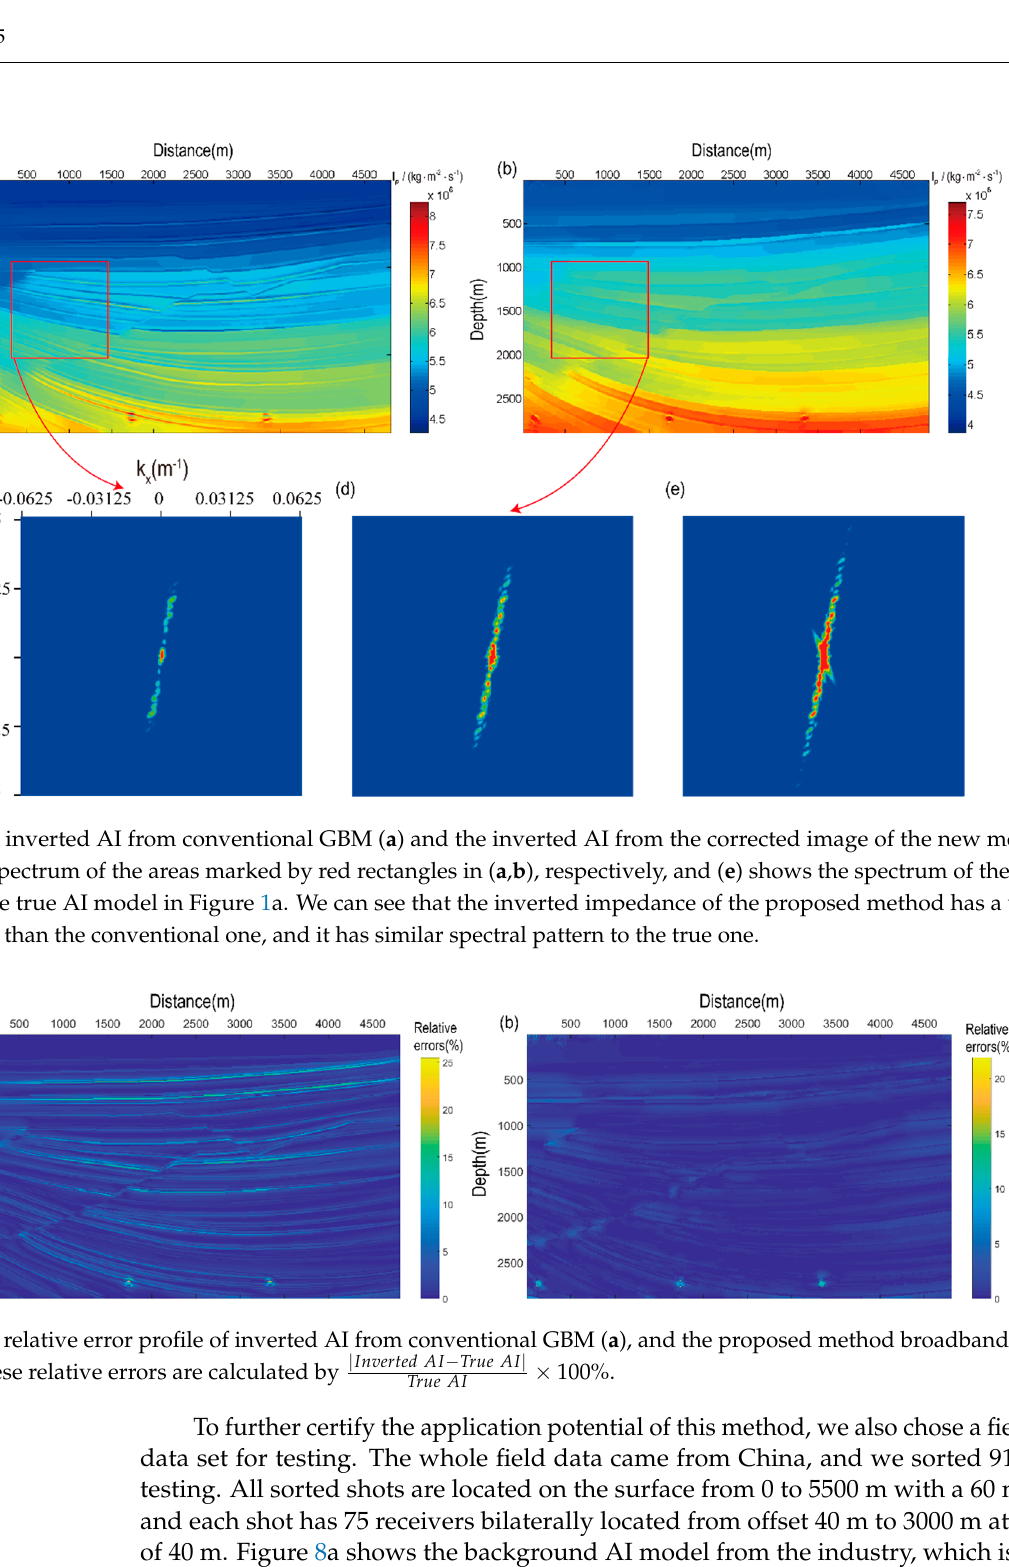
| . − True AI | | × . True AI